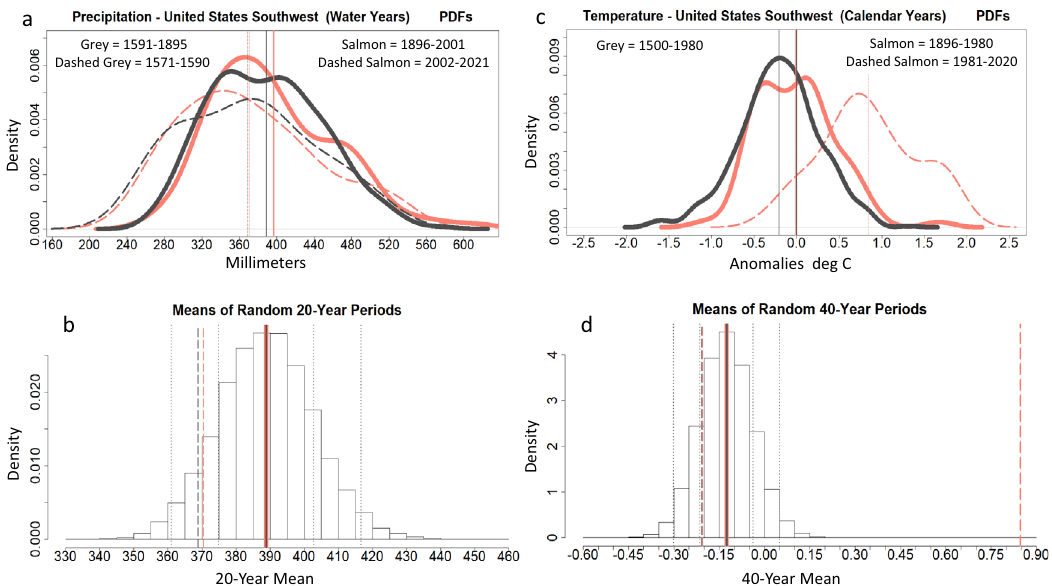
Fig. 3 Probabilistic characteristics of Southwest historical water year precipitation and calendar year annual mean temperature. a solid curves show estimated PDFs for RECON (dark gray) and INST (salmon) precipitation data, removing earliest and most recent 20-year periods (1571 – 1590 from RECON and 2002 – 2021 from INST). Solid vertical lines indicate means of the retained time periods (1591 – 1895 for RECON and 1896-2001 for INST). Dashed curves show estimated PDFs for 1571 – 1590 and 2002 – 2021 drought periods and dashed vertical lines their means. b Histogram of means of random 20- year samples (with replacement, n = 10,000) from full RECON + INST precipitation time series. Solid vertical line indicates overall mean of sample means. Dashed vertical lines indicate means of 1571 – 1590 and 2002 – 2021 periods, as above. Dotted vertical lines indicate + -1 and + -2 SDs for overall mean. c Solid curves show estimated PDFs for RECON (1500 – 1980) and INST temperature data (1896 – 1980, removing the most recent 40-year period). Solid vertical lines at 0 indicate mean over 1896 – 1980 for INST and over recalibration period (1904 – 1980) for RECON. Solid vertical line near − 0.2 indicates RECON data mean over 1500 – 1980 period. Dashed curve shows estimated PDF for 1981 – 2020 and dashed vertical line its mean. d Histogram of means of random 40-year samples (with replacement, n = 1,000,000) from full RECON + INST temperature time series. Solid vertical line indicates overall mean of sample means. Dashed vertical line near 0.85 indicates mean of 1981 – 2020 period, as above. Dashed salmon-gray vertical line indicates 1500 – 1980 mean for RECON + INST data. Histogram y -axis values represent relative densities, not densities normalized to